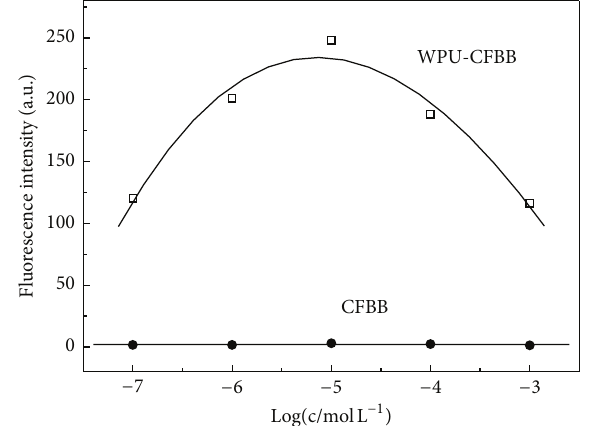
Figure 8: Fluorescence intensity of WPU-CFBB and CFBB at dif- ferent concentrations under 325 nm